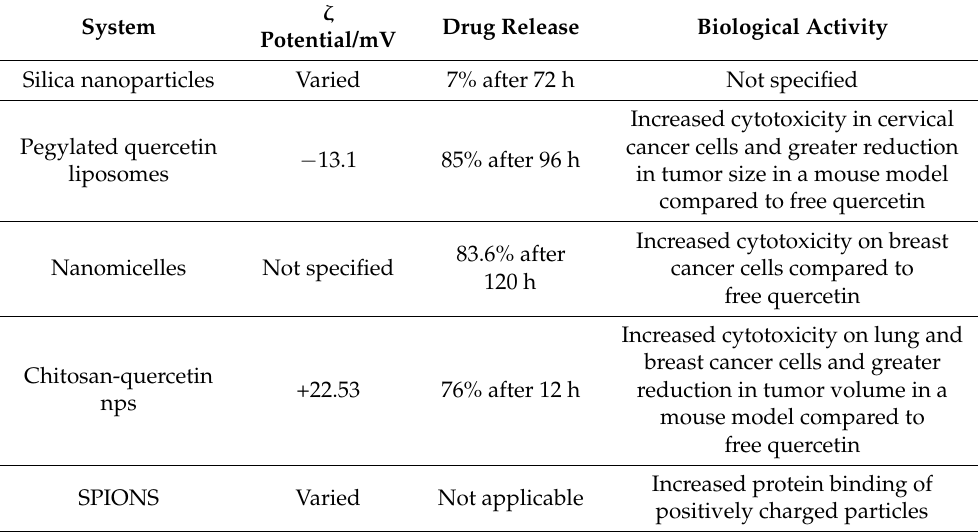
Table 6. Comparison of fabricated PLGA-chitosan folic acid system with previously reported